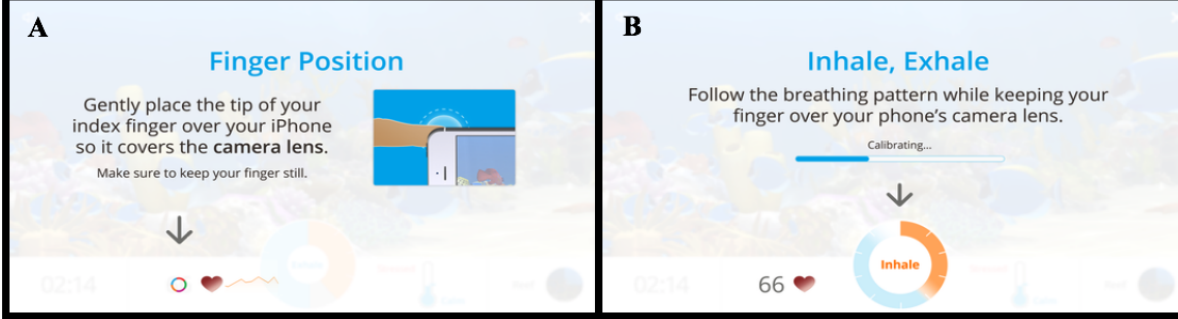
Figure 1. On-screen instructions for obtaining heart rate variability measurement and calibrating breathing guidance.